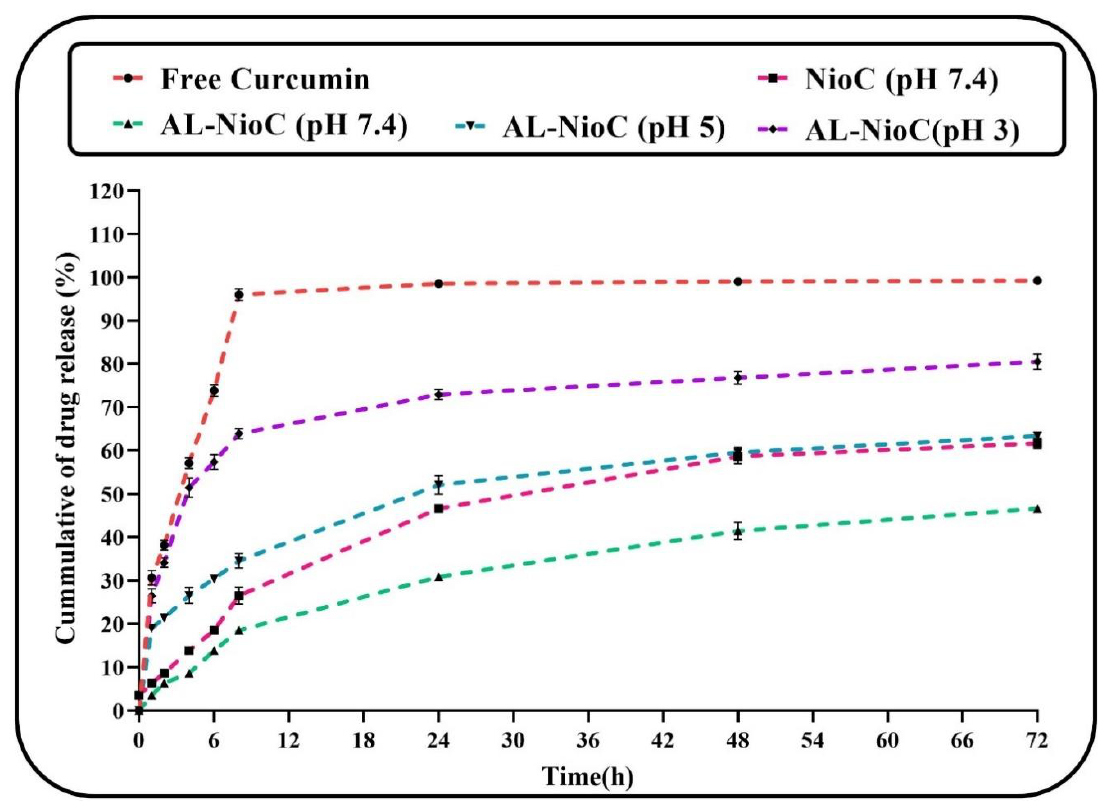
Figure 6. Release status of free curcumin (in vitro) beside investigated impact of pH on the release status of curcumin in optimum formulation of curcumin-loaded niosomes. Table 9. The dynamic release models and the factors gained for niosomal formulation in optimum condition.